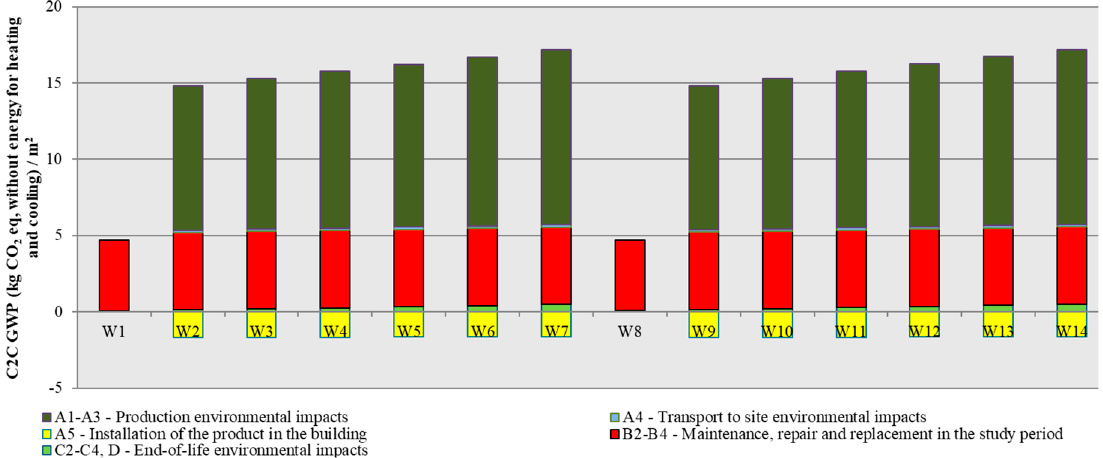
Figure 3. C2C Global Warming Potential (GWP, in kg CO 2 eq, without energy for heating and cooling) / m 2 of the external wall alternatives with ICB.